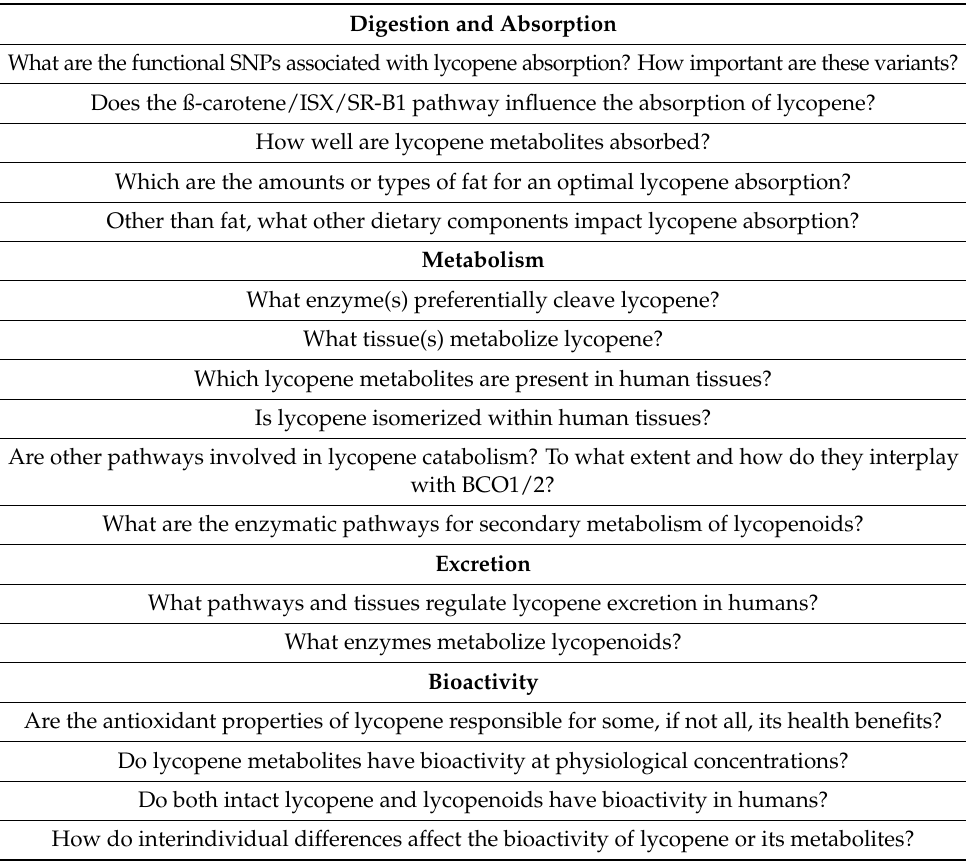
Table 1. Gaps in knowledge regarding lycopene digestion, absorption, metabolism, excretion, and